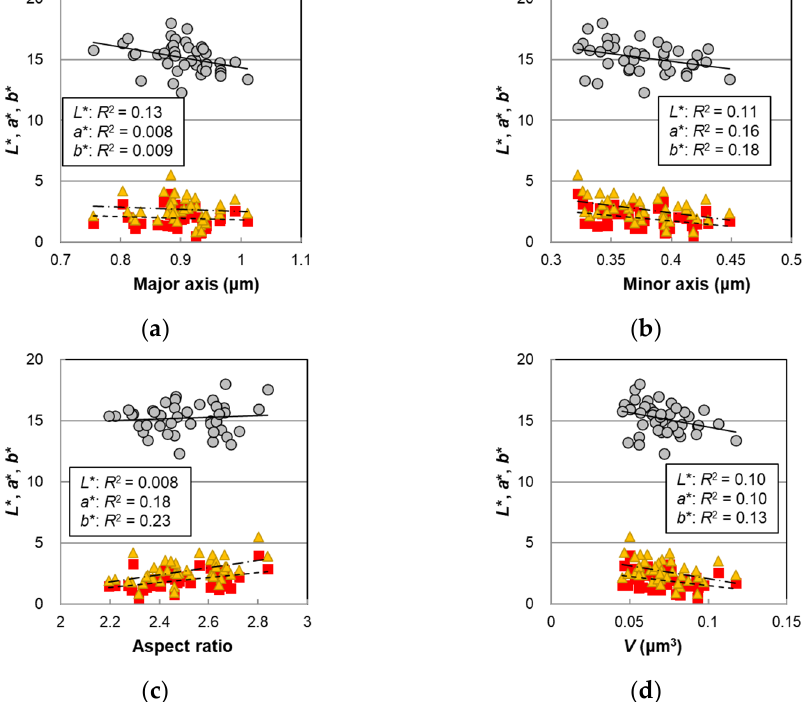
Figure 5. The hair color parameters L *, a *, and b * plotted against morphological parameters deter- mined for the melanosomes isolated from non-chemically treated Japanese male pigmented hairs. Circles denote L *; squares denote a *; and triangles denote b *. Lines represent the fitted curves. Solid lines denote L *; dashed lines denote a *; and dot-and-dash lines denote b *. ( a ) The color values vs. mean major axis, p = 0.020 ( L *), 0.58 ( a *), and 0.56 ( b *); ( b ) the color values vs. mean minor axis, p = 0.032 ( L *), 0.0099 ( a *), and 0.0048 ( b *); ( c ) the color values vs. mean aspect ratio, p = 0.57 ( L *), 0.0050 ( a *), and 0.0013 ( b *); and ( d ) the color values vs. mean volume V with an assumption of an ellipsoid, p = 0.039 ( L *), 0.037 ( a *), and 0.017 ( b *). The coefficients of determination are shown in each figure.